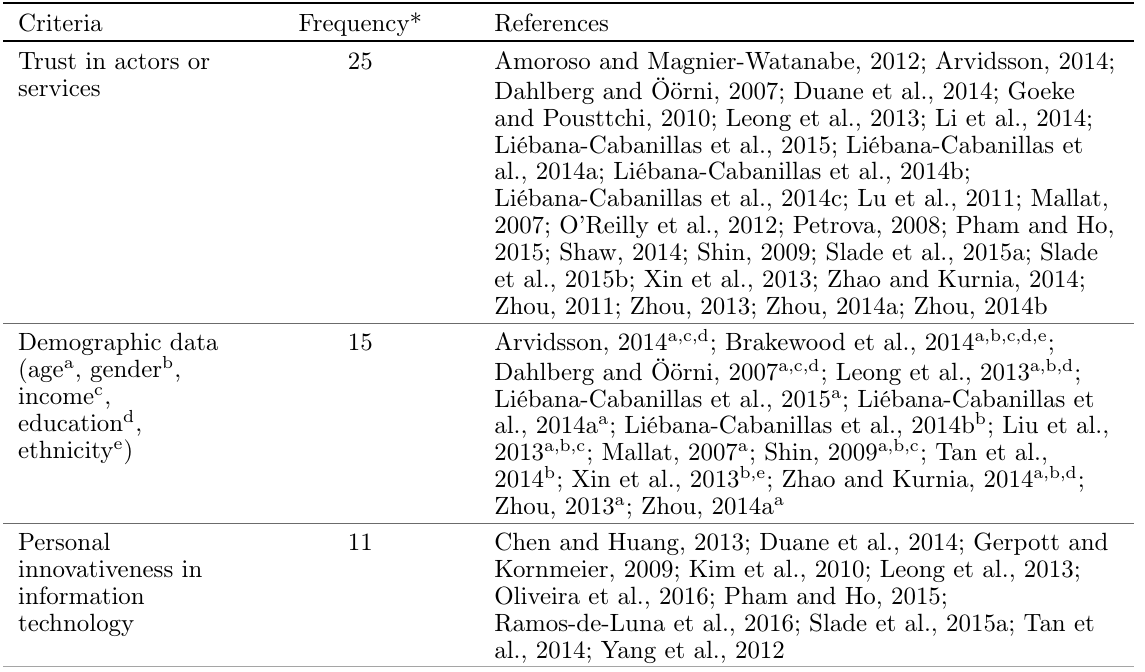
Table C.4. Constructs related to customer’s